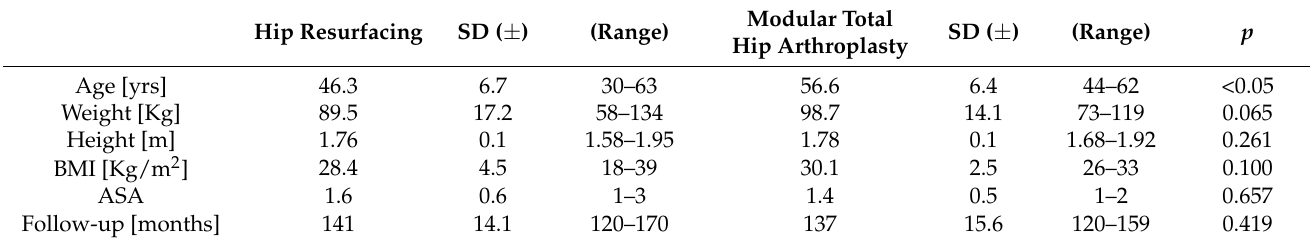
Table 1. Baseline Patients Characteristics.